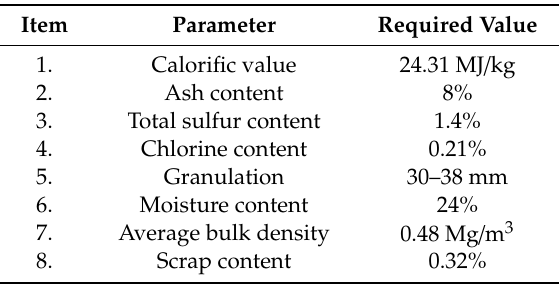
Table 4. Parameters of obtained hybrid fuel.